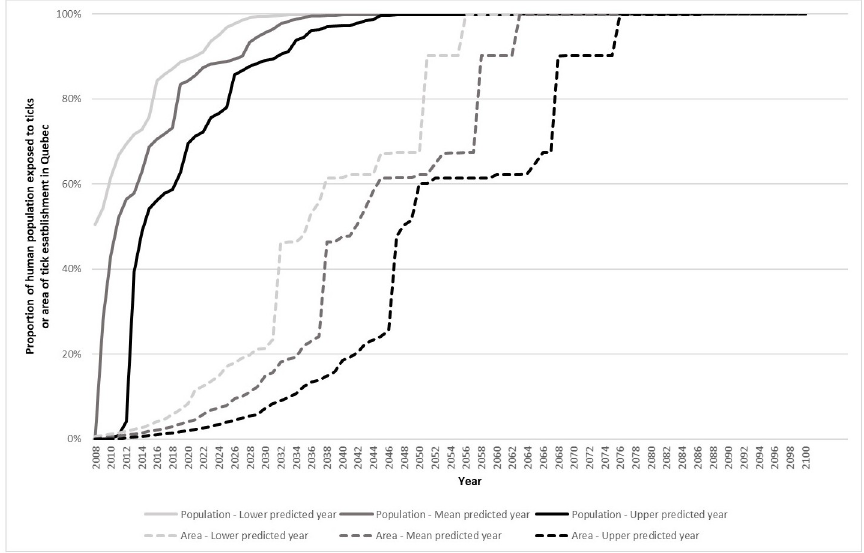
Fig 2. Predicted increase in the area of tick establishment and the proportion of the human population living in municipalities with established tick population in Que´bec from 2008 to 2100. Dashed lines show the percentage of the surface area of the province of Que´bec predicted to contain an established tick population by the lower, mean and upper predicted years (light, medium and dark grey, respectively). Solid lines show the percentage of the Que´bec human population living in areas predicted to have an established tick population by the lower, mean and upper predicted years (light, medium and dark grey lines,